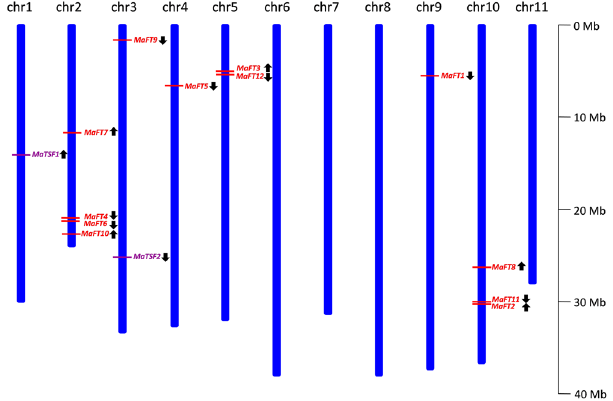
Figure 2. Chromosome distribution of banana FT and TSF -like genes. The red lines indicate the position of the gene and black arrows indicate the direction of transcription.